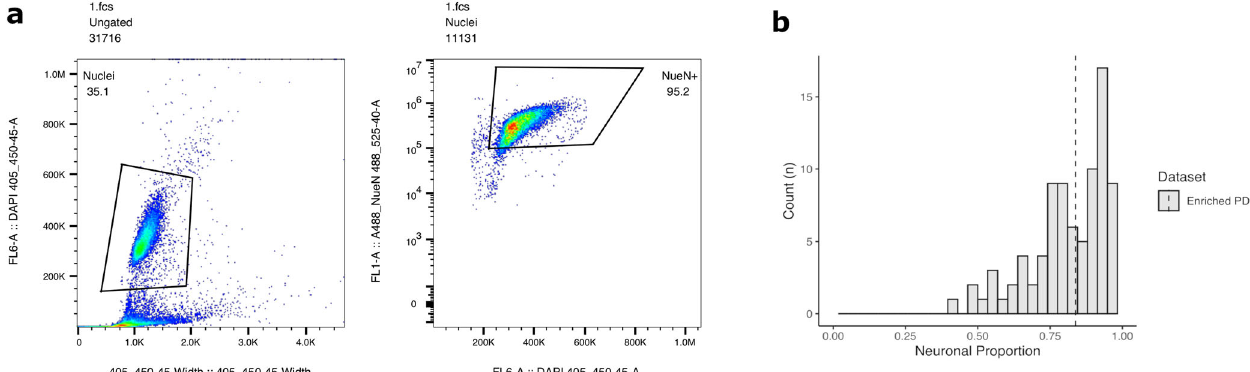
Fig. 1 Neuronal enrichment validation by fl ow cytometry and CETS analysis. a NeuN + nuclei were identi fi ed using DAPI pulse area vs. width using the 405-450/45 channel for all nuclei (left) followed by NeuN-AlexaFluor488 bright events 488-525/40 (right). The percentage of NeuN + nuclei is provided in the top-right corner. b Histogram of estimated neuronal proportion (vs. glial) for enriched PD NeuN + nuclei population. Proportions of neuronal and glial cell types were estimated for MACS-sorted NeuN + nuclei samples using the CETS R package during EPIC array data processing. Average proportion of neurons (vertical dotted line) was estimated to be 83.8% across all n = 99 samples included in analysis.